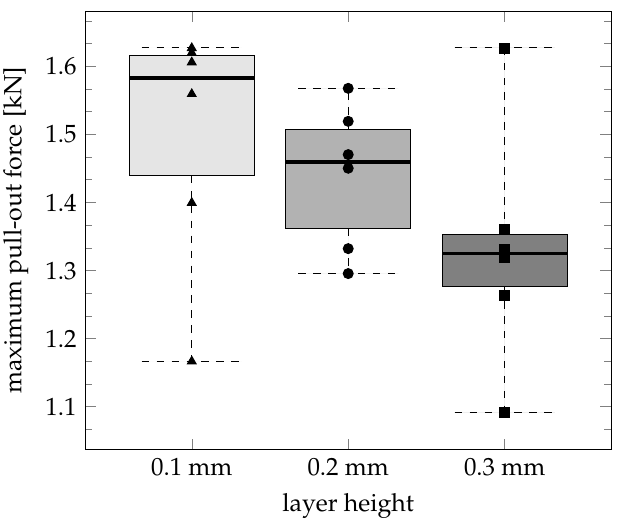
Figure 13. Maximum pull-out forces for variations of the layer height (six specimens each). The maximum pull-out force decreased with increasing layer height. At a layer height of 0.1 mm, the median maximum pull-out force was approximately 1.6 kN, and the associated averaged displacement was 0.6 mm. The dispersion of the measured values is the largest in comparison with the other considered layer heights—in particular, the minimum value shows a large deviation from the median. The test specimens produced with a layer height of 0.2 mm achieved a median pull-out force of is approximately 1.5 kN and an averaged displacement of 0.6 mm with a similarly large interquartile range. However, the deviation of the maximum and minimum values from the median were significantly smaller.